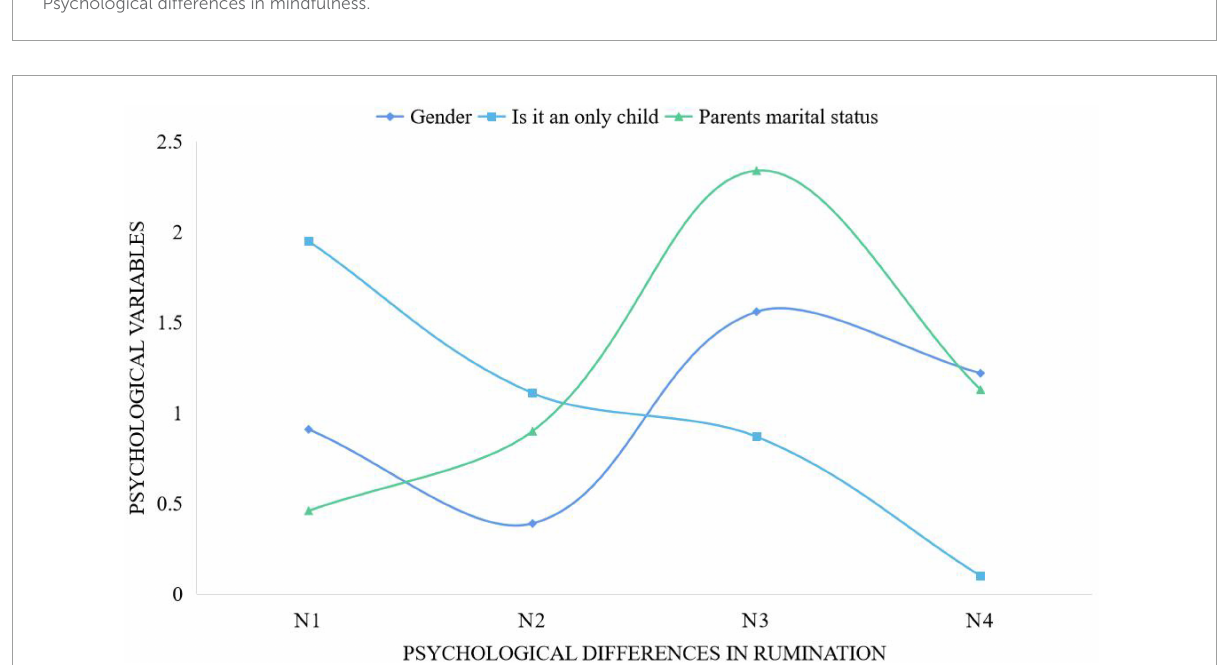
FIGURE6 Psychological differences in